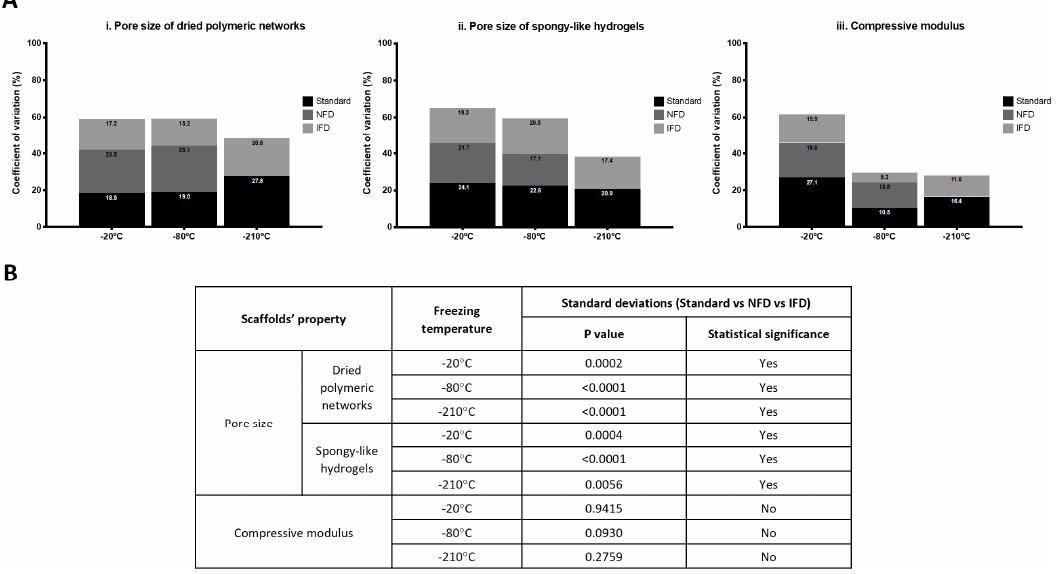
Figure 4. Scaffolds reproducibility. ( A ) Representation of the coefficient of variation of the pore size of 1.25% GG (i) dried polymeric networks and (ii) spongy-like hydrogels, and of the (iii) compressive modulus of spongy-like hydrogels according to the tested freezing conditions, standard method, NFD and IFD at − 20, − 80, and − 210 °C. ( B ) p values obtained from the Brown–Forsythe test showing the statistical significance of the standard deviations for the pore size and compressive modulus among the different freezing devices (standard method, NFD, and IFD).